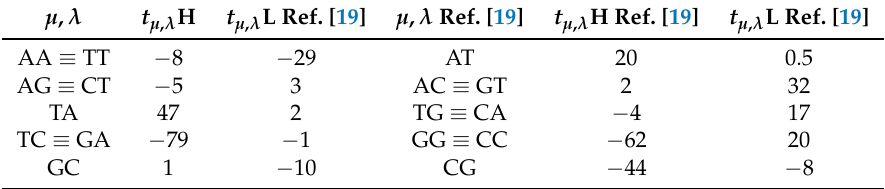
Table 2. The HOMO/LUMO hopping integrals t µ , λ , in meV, between successive base pairs µ , λ . µ , λ t µ , λ H t µ , λ L Ref. [19] µ , λ Ref. [19] t µ , λ H Ref. [19] AA ≡ TT